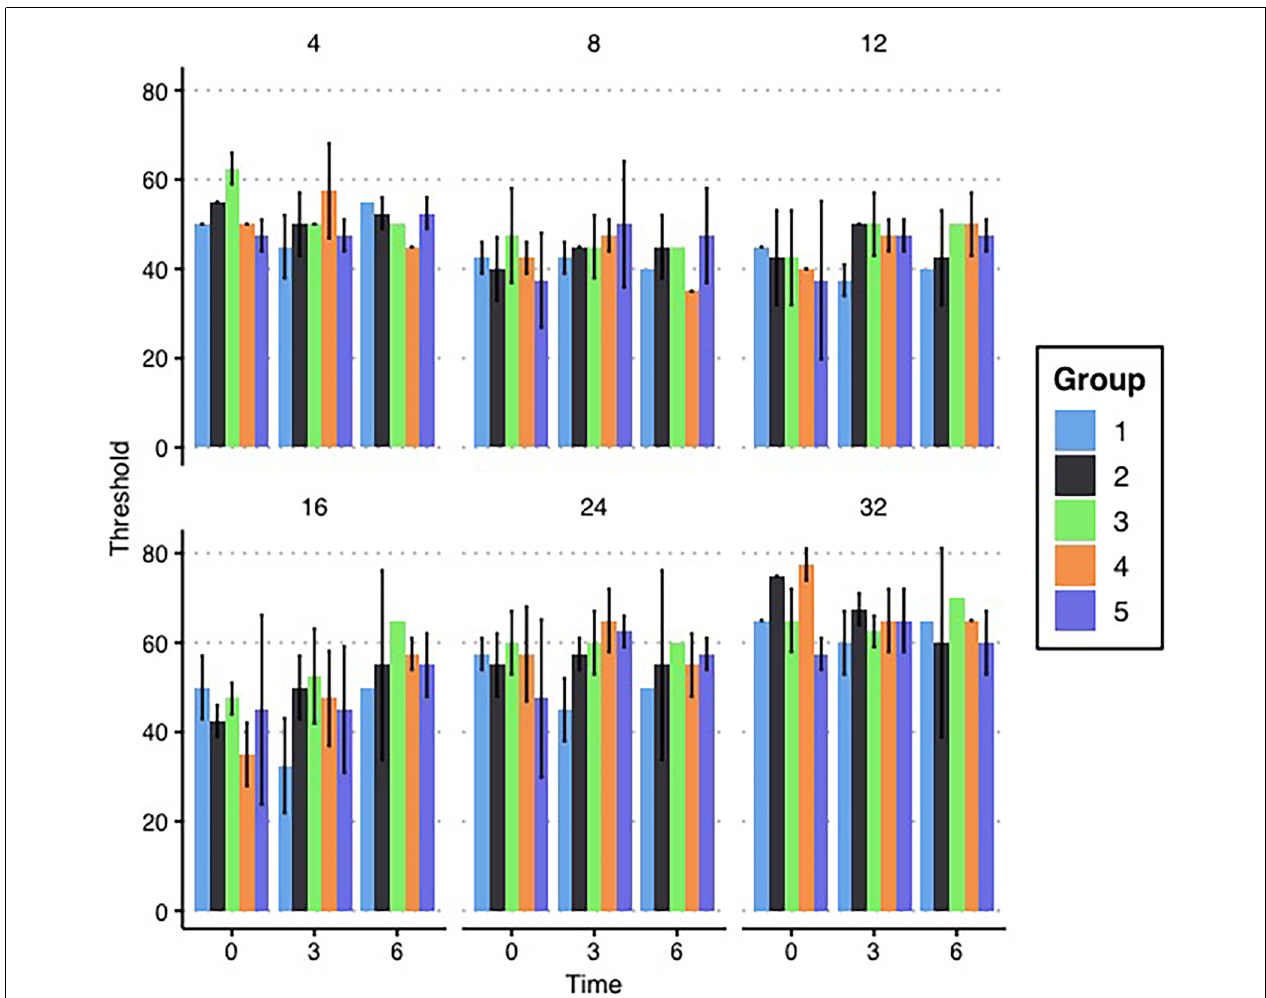
FIGURE 2 | Breeder ABR results. Mean ABR thresholds for each group of female breeding mice are depicted by the bars in each panel. Thresholds are grouped with the first set in each panel depicting mean thresholds before enrollment in the study and the next sets indicating the ABR thresholds at 3 and 6 months, respectively. Each panel represents a tested frequency. No significant differences exist between groups. Error bars represent ± 1 standard deviation